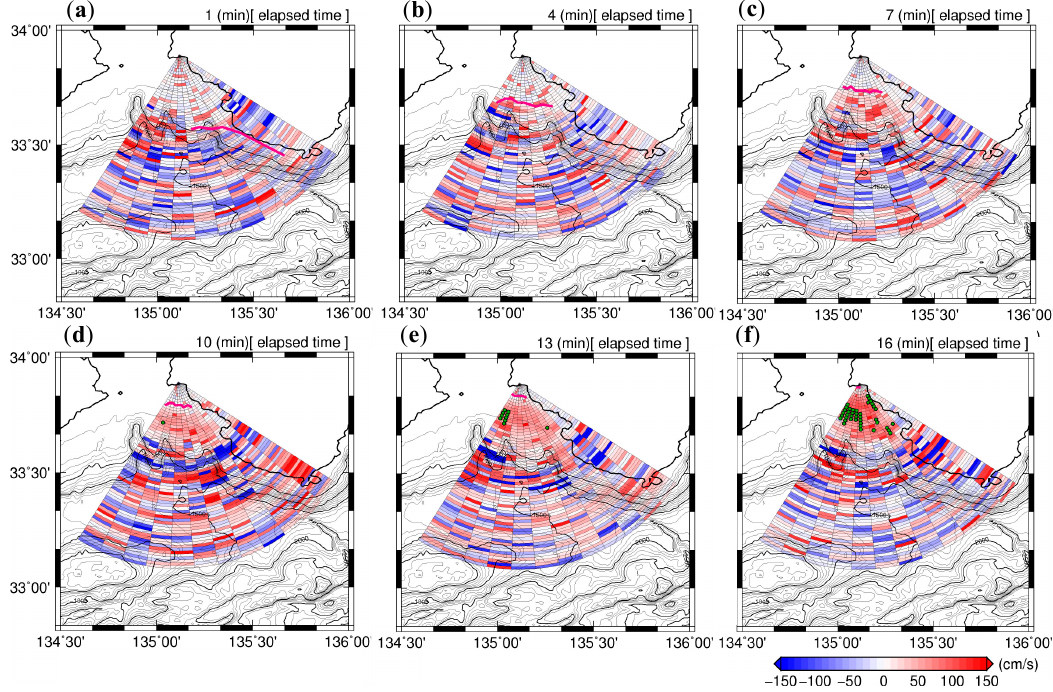
Figure 9. Same as Figure 8, but for the 02271300 scenario.